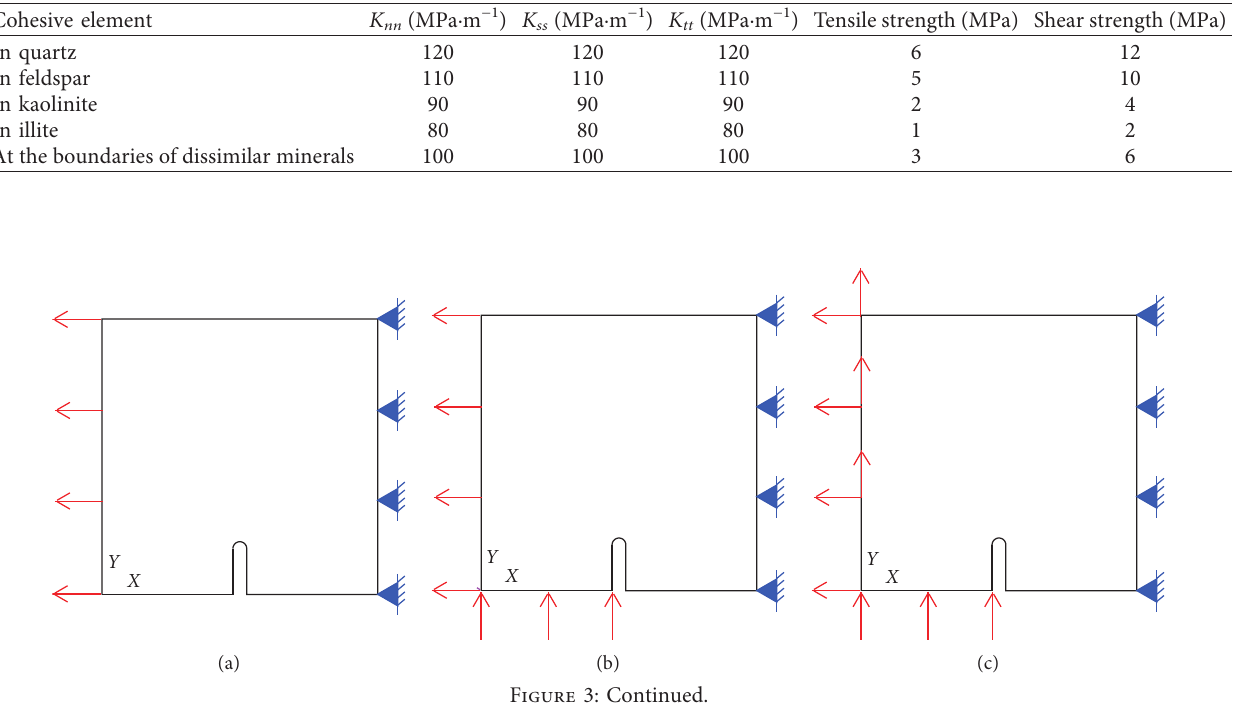
Table 2: Parameters of cohesive elements in minerals (at boundaries of CPE4) and cohesive elements at boundaries of dissimilar minerals. Cohesive element